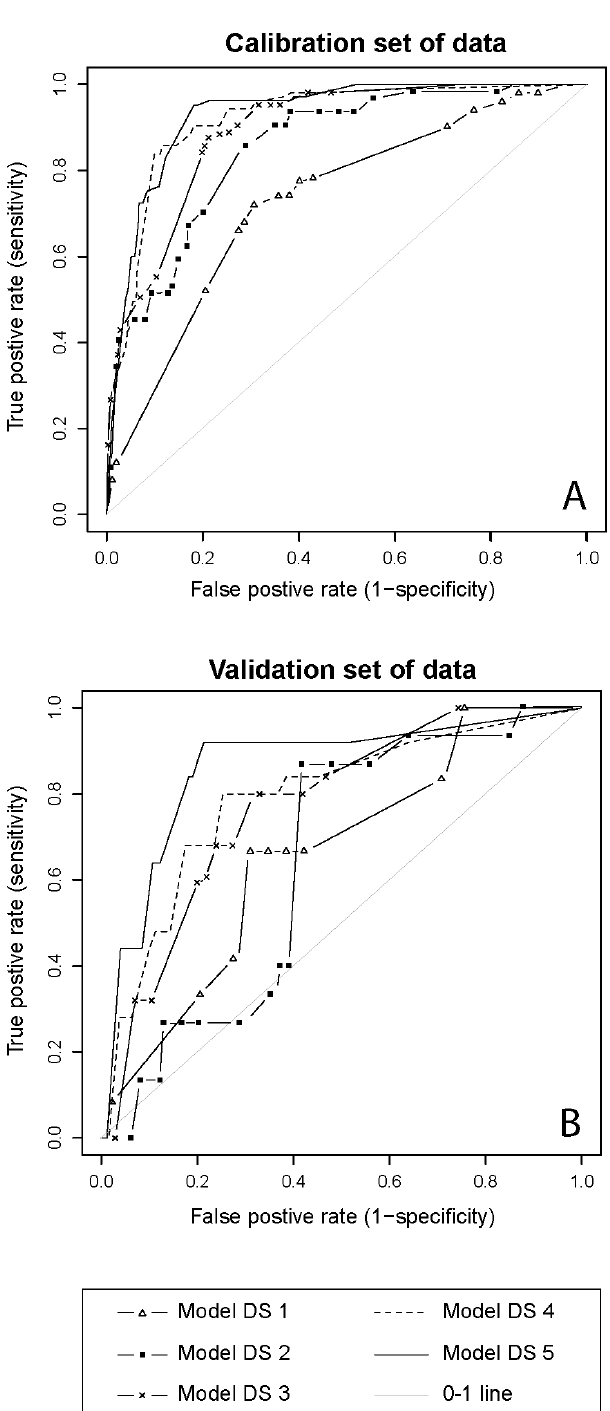
Fig. 10. Receiver operator characteristics (ROC) curves obtained for the different models, (A) calibration data sets and (B) validation data